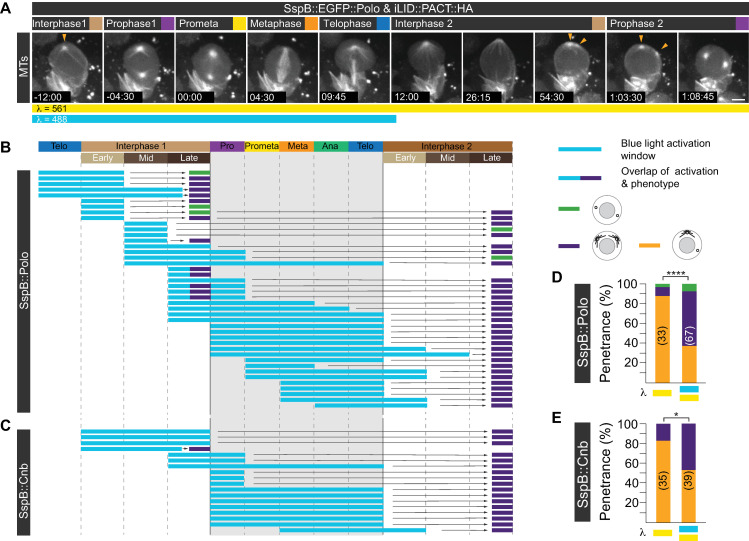
Establishment of centriolar asymmetry during mitosis is required for biased interphase MTOC activity.(A) Representative wild-type neuroblast expressing SspB::EGFP::Polo (not shown) together with the microtubule marker mCherry::Jupiter (white) and iLID::PACT::HA (not shown). As indicated with the cyan and yellow color bars underneath the image sequence, this neuroblast was exposed to both 488 nm and 561 nm during the first division but only to 561 nm in the second division. Yellow arrowheads indicate 2 active MTOCs in the interphase 2 and prophase 2. Summary of all optogenetic experiments for (B) SspB::EGFP::Polo and (C) SspB::mDendra2::Cnb and iLID::PACT::HA expressing neuroblasts. Blue-light exposure and resulting phenotype are indicated with the colored bars (see legend on the right). Because neuroblasts do not divide in synchrony, they were exposed to blue light at different cell-cycle stages. This experiment was repeated more than 3 times independently. Bar graphs representing the phenotypic penetrance (in %) of larvae expressing (D) SspB::EGFP::Polo and iLID::PACT::HA or (E) SspB::mDendra2::Cnb and iLID::PACT::GFP with (cyan and yellow bars) or without (yellow bar only) blue-light exposure. The number of scored divisions are indicated on the bars. Fisher’s exact test: SspB::Polo with and without blue-light exposure: p = 1.944 × 10−6. SspB::Cnb with and without blue-light exposure; p = 0.0123. Time stamps are shown in hh:mm:ss and scale bar is 5 μm. Numerical data for panels D and E can be found in the file S1 Data.xlsx. Cnb, Centrobin; EGFP, enhanced green fluorescent protein; GFP, green fluorescent protein; HA, hemagglutinin; iLID, improved light-induced dimer; MTOC, microtubule organizing center; PACT, Pericentrin-AKAP-450 containing targeting; SspB, Stringent starvation protein B.